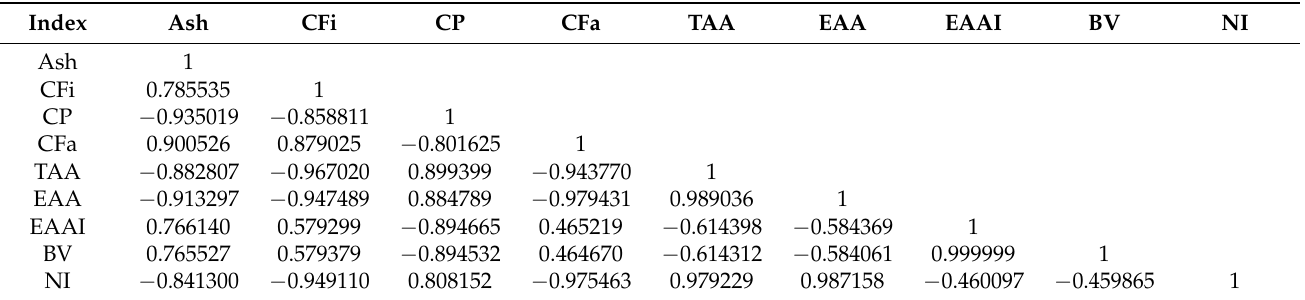
Table 7. The correlational analysis of nutritional indicators of M. importuna under different rotation